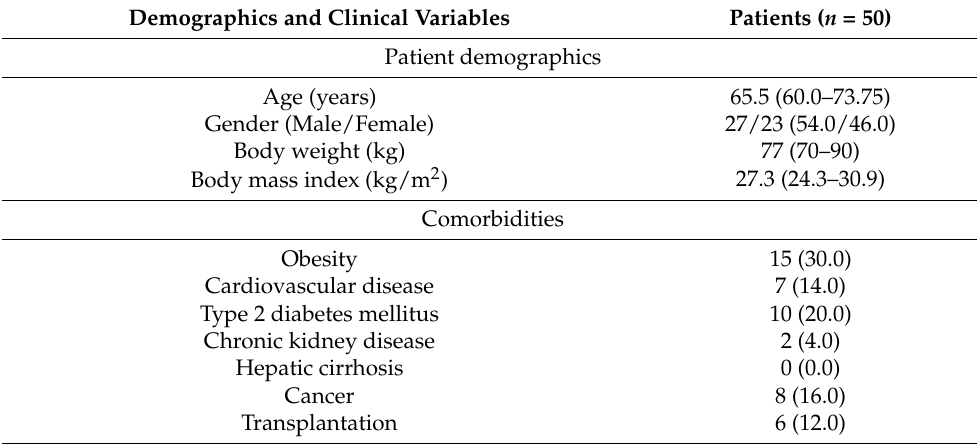
Table 1. Demographic and clinical variables of critically ill patients undergoing at least one TDM assessment of voriconazole during treatment for COVID-associated pulmonary